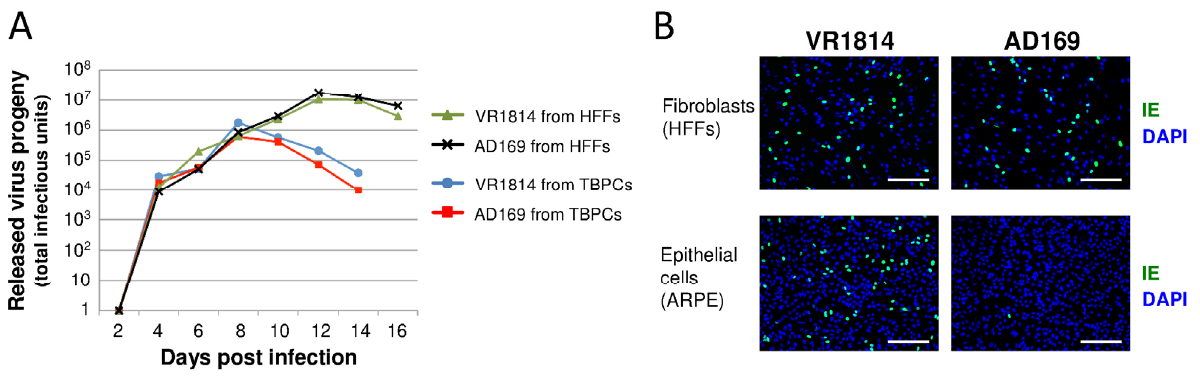
Figure 3. ( A ) Infected TBPCs release progeny virions. CM from VR1814- and AD169- infected TBPCs and HFFs (MOI 0.1) were collected at the indicated time points and titrated on HFFs. ( B ) Progeny virions from TBPCs retain tropism. CM from VR1814- and AD169-infected TBPCs (8 dpi) was added to HFFs and ARPE-19 cells, and IE1 was immunostained (1 dpi). Nuclei were counterstained with DAPI. Scale bar = 200